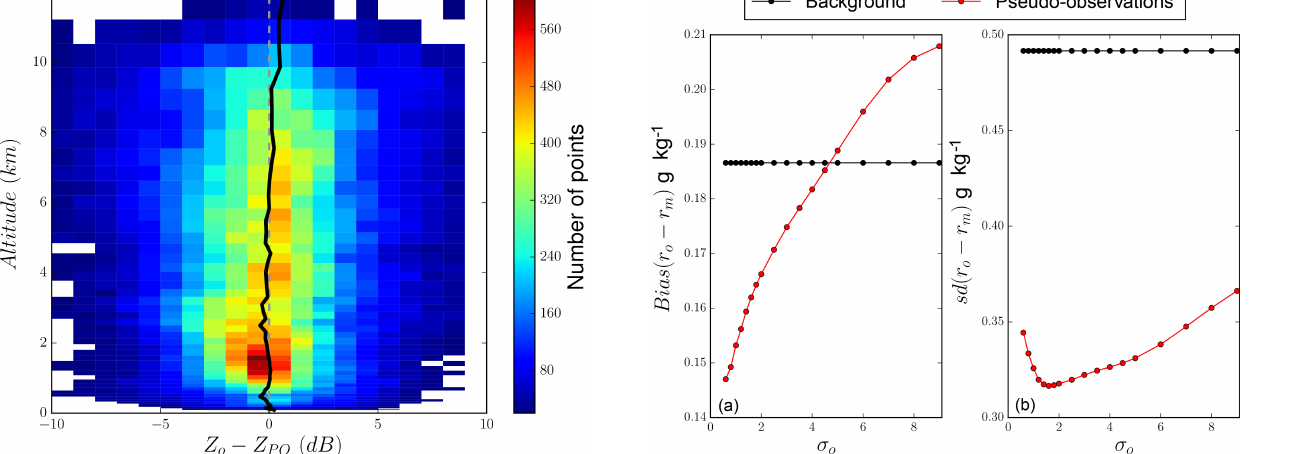
Figure 3. Contoured frequency by altitude diagram (CFAD) of the differences between the observed reflectivity and the bias-corrected reflectivity pseudo-observations. The residual bias after applying the bias correction is indicated by the black line.